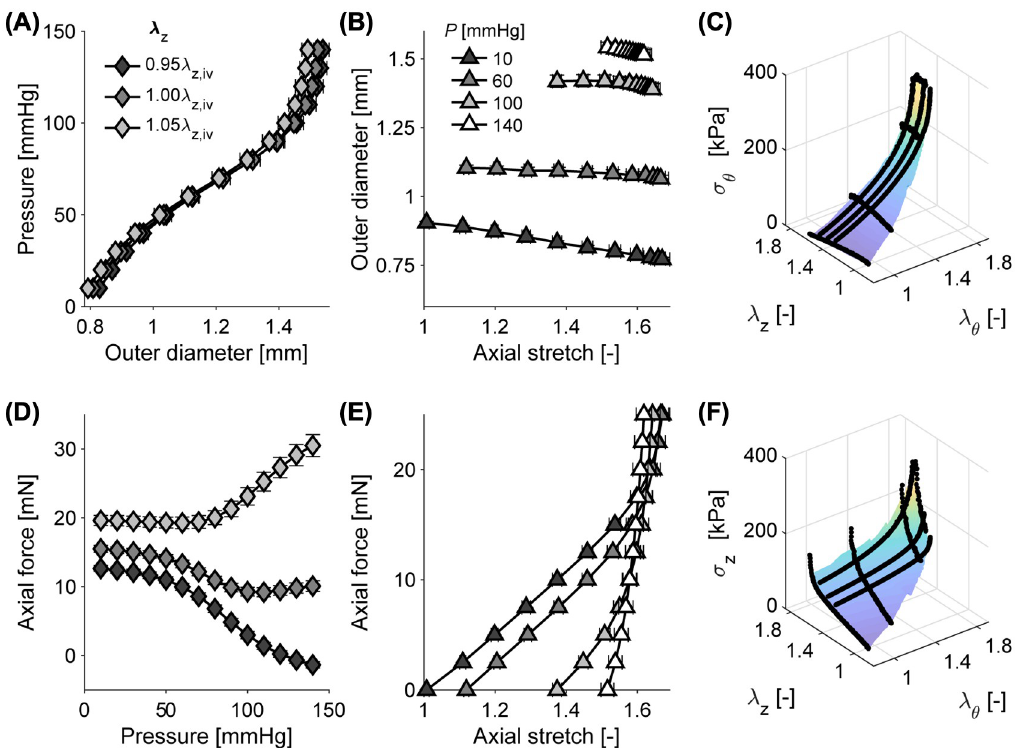
Fig 2. Illustrative experimental biomechanical data used for deep learning. (A,D) Data from distension experiments at three constant levels of axial stretch ( λ z ), relative to the in vivo value of axial stretch λ z ,iv . (B,E) Data from axial extension experiments at four constant pressures ( P ). Symbols and whiskers indicate means ± standard errors across these 8 wild-type (WT) control samples. (C,F) Circumferential ( σ , C) and axial ( σ , F) stress as a function of λ and λ for one representative WT sample. θ z θ z